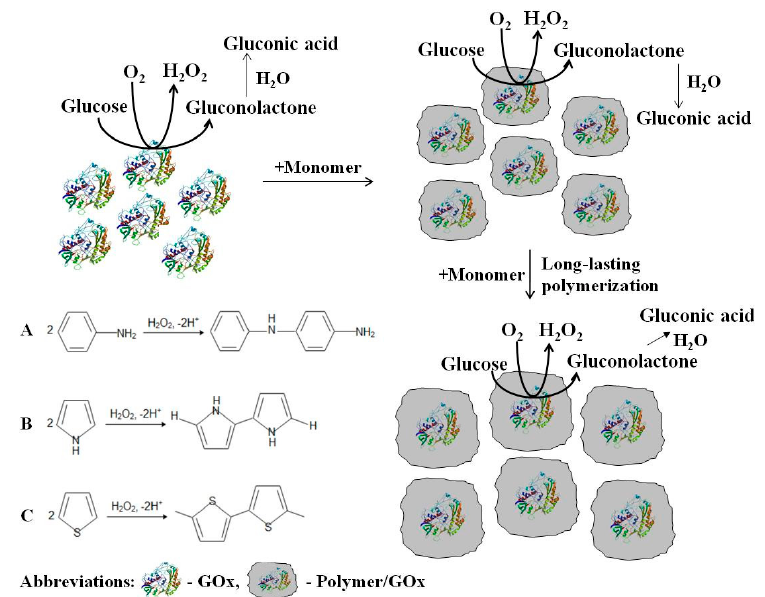
Figure 1. The formation of composite conducting polymer nanoparticles with embedded glucose oxidase (GOx) by enzymatic polymerization and the schematic presentation of polyaniline (PANI) ( A ), polypyrrole (Ppy) ( B ), and polythiothene (PTh) ( C ) polymerization mechanisms.